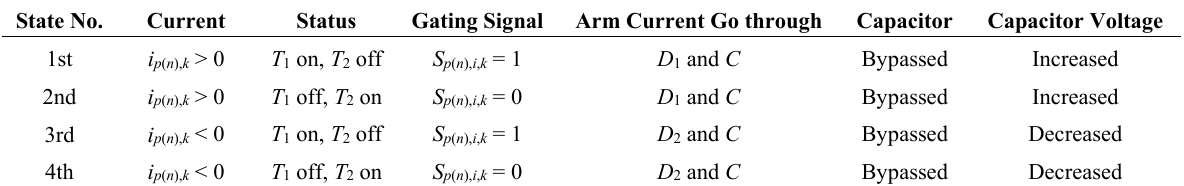
Table 4. Failure Mechanism of Short-Circuit Faults in T 1 or T 2 .